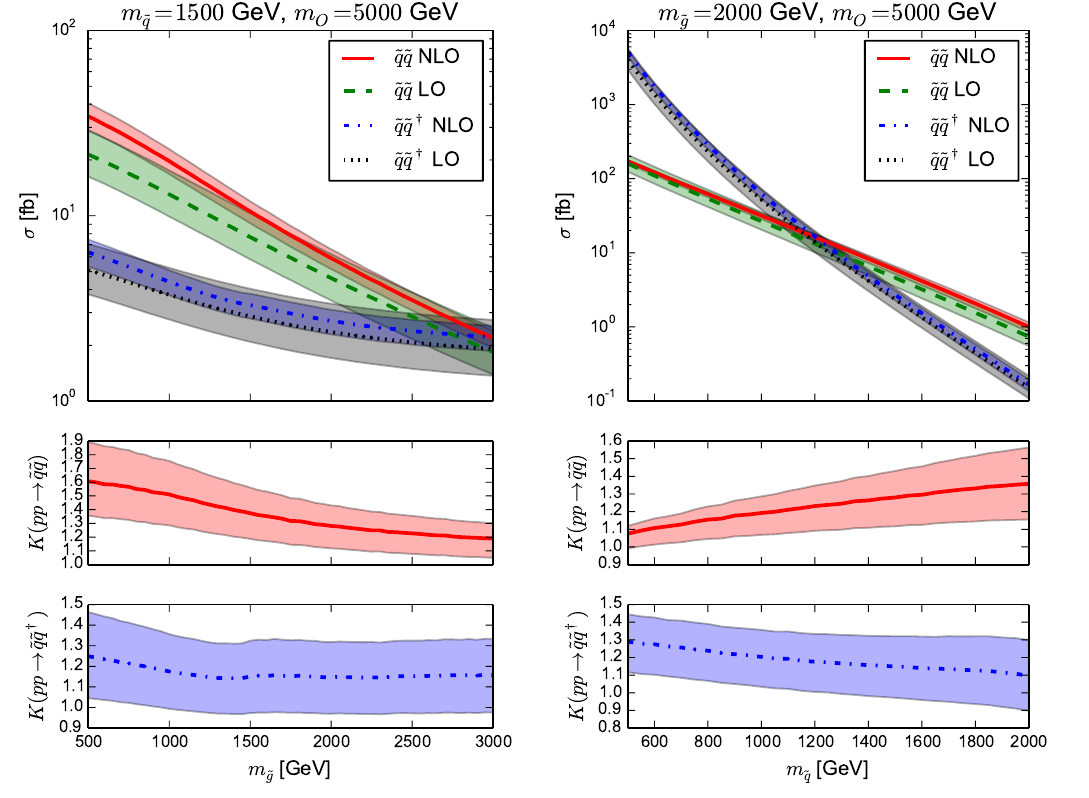
Figure 13. Total LO and NLO cross section as function of the gluino (left) and common squark mass (right) with uncertainties. Shown are ~ q ~ q and ~ q ~ q y production summed over all possible (cid:13)avour combinations as well as the corresponding K-factors. The bands give the 68% CL combined scale and pdf uncertainties as described in the